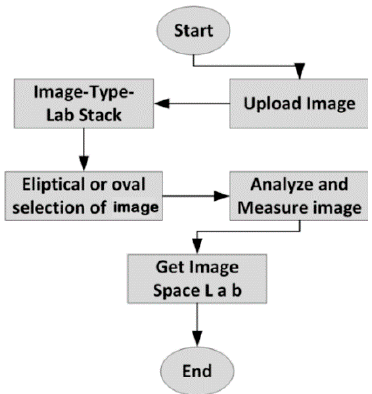
Figure 2. Flowchart of the ImageJ using to obtain color parameter (L*, a*, and b*). Descriptive variables (L* a* and b* ) related to color were achieved with the ImageJ software. L* variant shows the degree of lightness to darkness, a* value indicates the degree of redness ( + ) to greenness ( − ), and b* value is the degree of yellowness ( + ) to blueness ( − ) [26]. The color value of L* have shown the brightness and it ranges from 0 to 100. The color coordinates a* and b* variants do not have a particular reading range. The average values of color parameters and standard errors were calculated (L*, a*, b*, C, and H) [27].